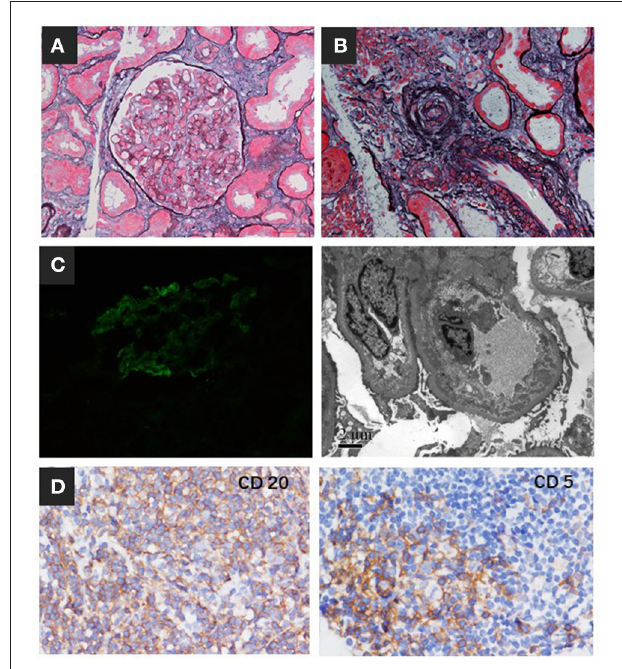
FIGURE 3 | Renal biopsy findings. (A) The glomerulus showed segmental endothelial cell proliferation and swelling (periodic acid-silver methenamine, Masson staining, × 400). (B) Interlobular renal arteries showed intimal swelling and contained mainly lucent amorphous material with a mucoid appearance, which we classified as mucoid intimal hyperplasia. (C) Immunofluorescence staining showed C3 deposits in the mesangial area. The expansion of the lucent subendothelial zone of the glomerular capillary had dense deposition in the subendothelial and mesangial area by EM. (D) Immunohistochemistry showed monotypic lymphocytes infiltrating the renal interstitium that were positive for CD20 and CD5.